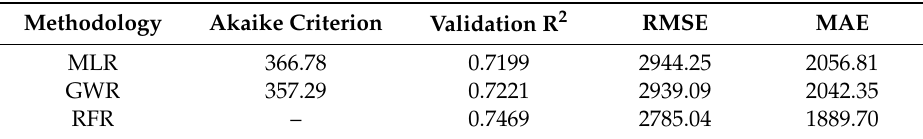
Table 4. Comparative reliability assessment results.